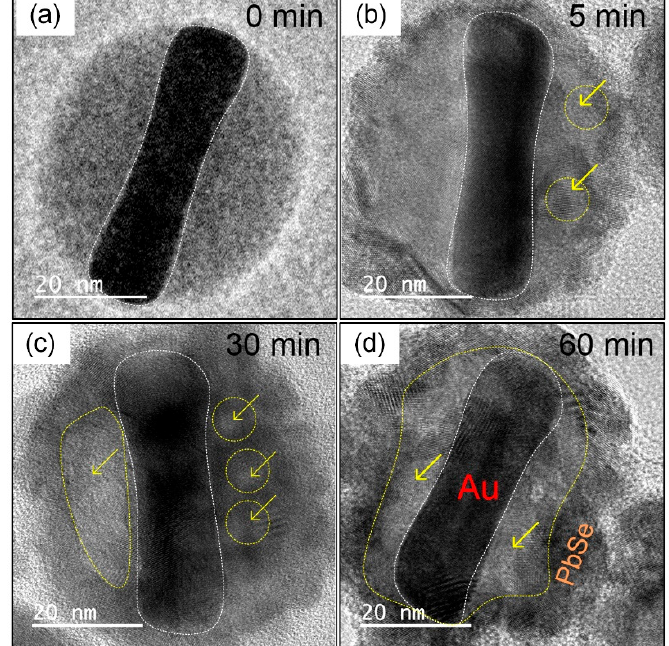
Figure 3. TEM images of ( a ) the initial Au@Se NRs and the products obtained at different reaction times of ( b ) 5 min, ( c ) 30 min and ( d ) 60 min for synthesis of Au–PbSe yolk-shell NRs. The yellow arrows indicate the positions of nanovoids.